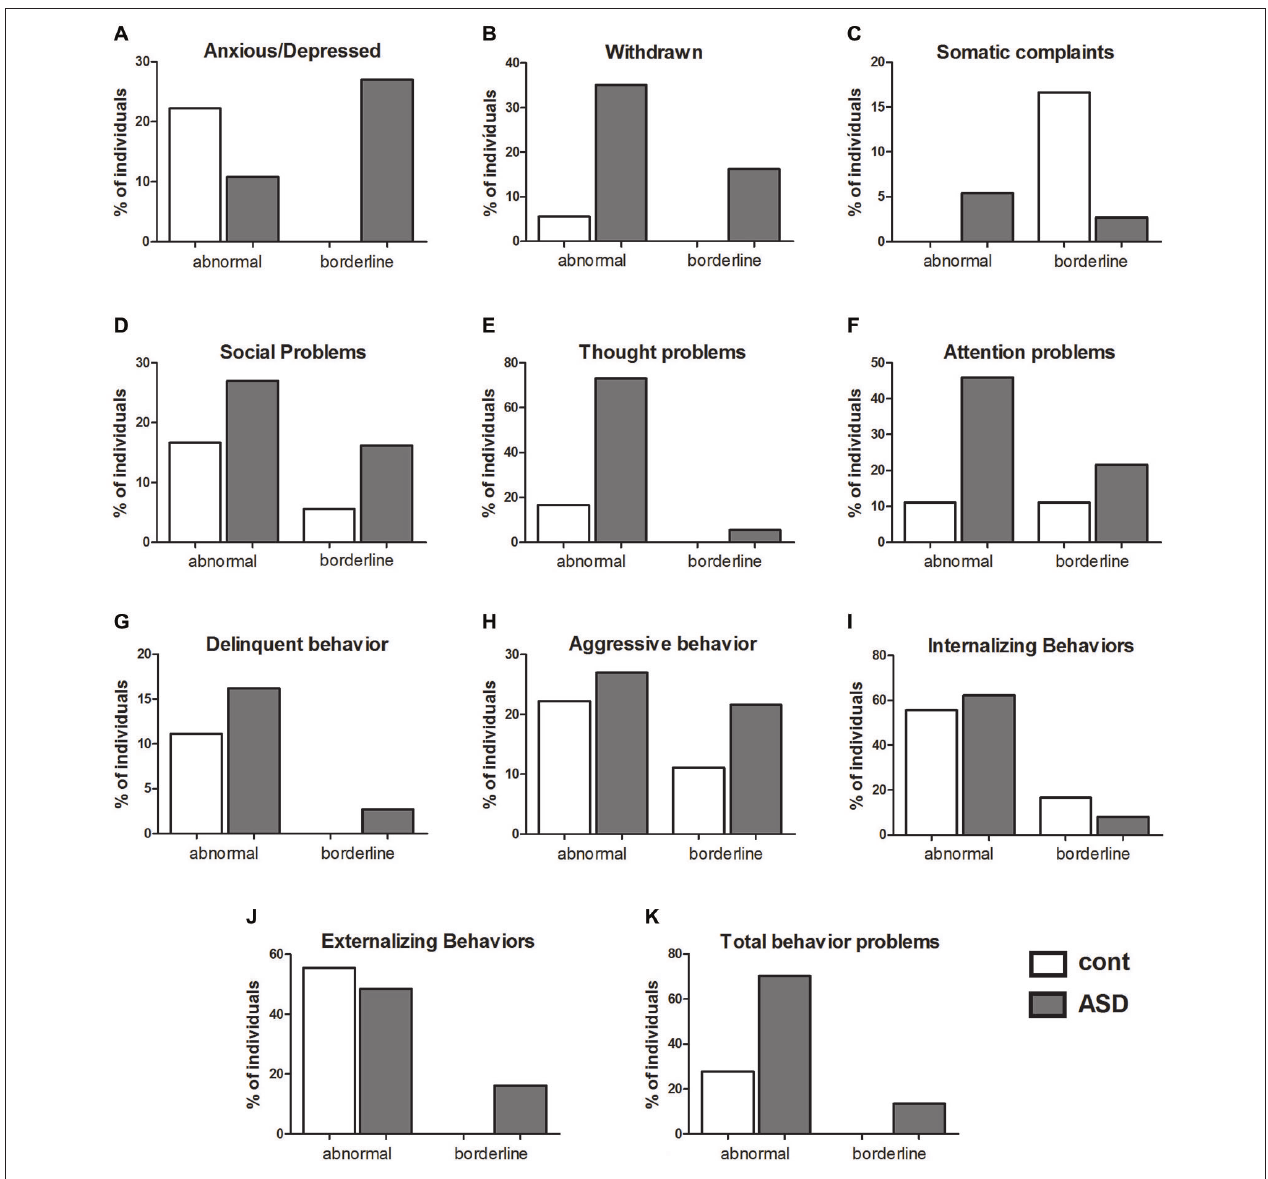
withdrawn; In (C) , somatic complaints; In (D) , social problems; In (E) , thought problems; In (F) , attention problems; In (G) , delinquent behavior; In (H) , aggressive behavior; In (I) , internalizing problems. N = 56 in the control group and 45 in the ASD group; In (J) , externalizing problems; and in (K) , total behavior